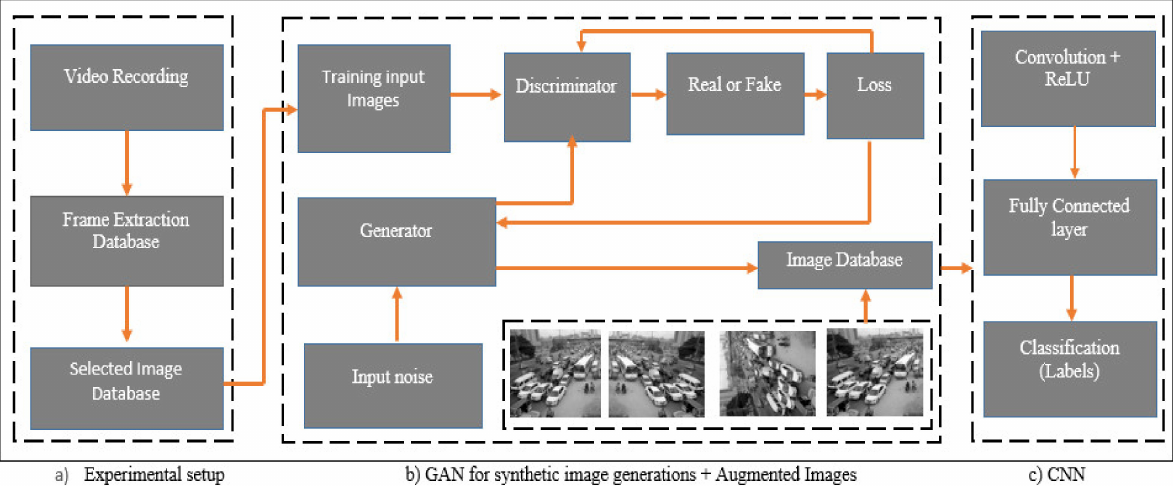
Figure 4. Architecture of the setup used with GAN along with CNN as the classifier.